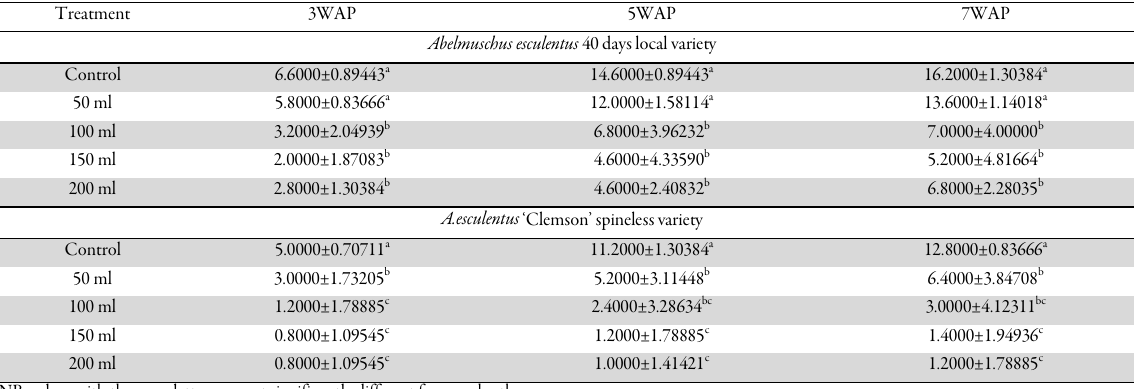
Table 4. Number of leaves of plants as affected by different concentrations of spent engine oil